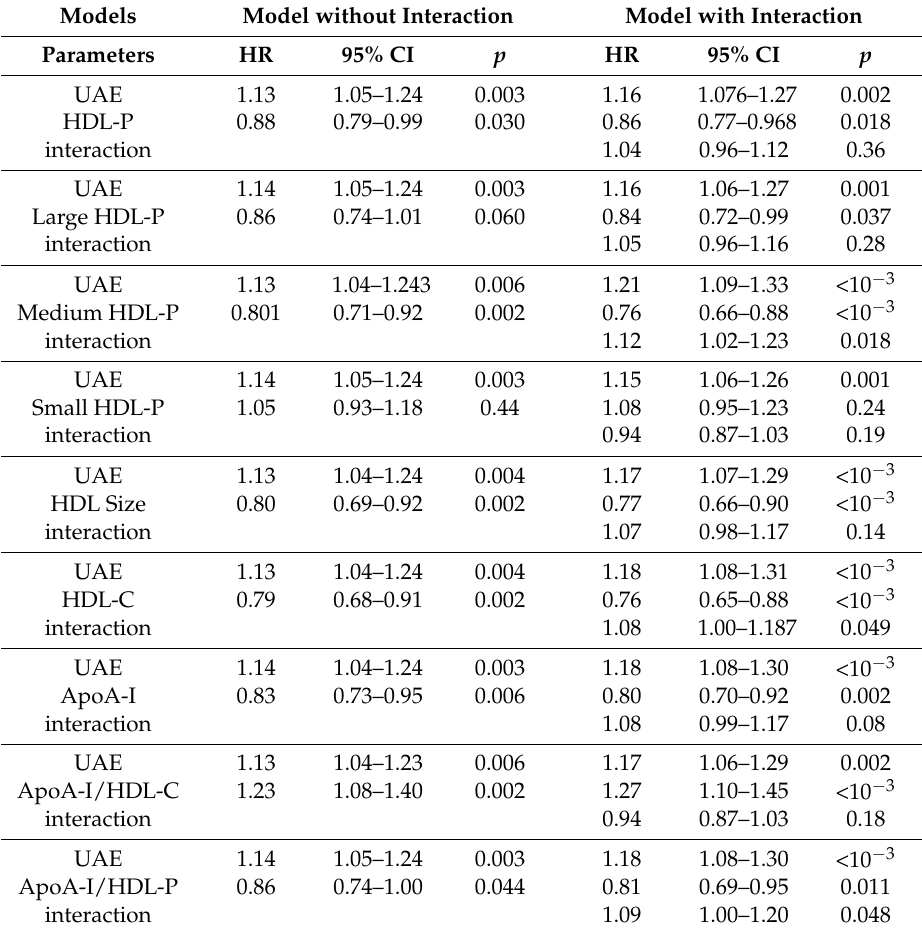
Table 6. Interaction of UAE with HDL-related parameters for second screening round as assessed by Cox proportional hazards models of cardiovascular event occurrence adjusted for gender, age, apoB, diabetes, past CVD history, CRP, and eGFR. Hazard ratios are per SD unit for all